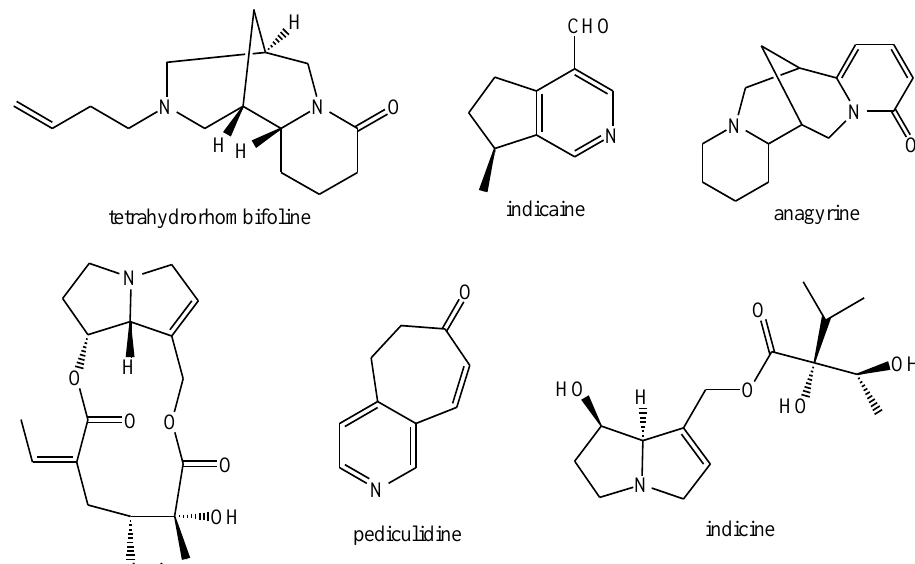
Figure 5. Alkaloids identified in Pedicularis species—part 1. Plants 2019 , 8 , x FOR PEER REVIEW